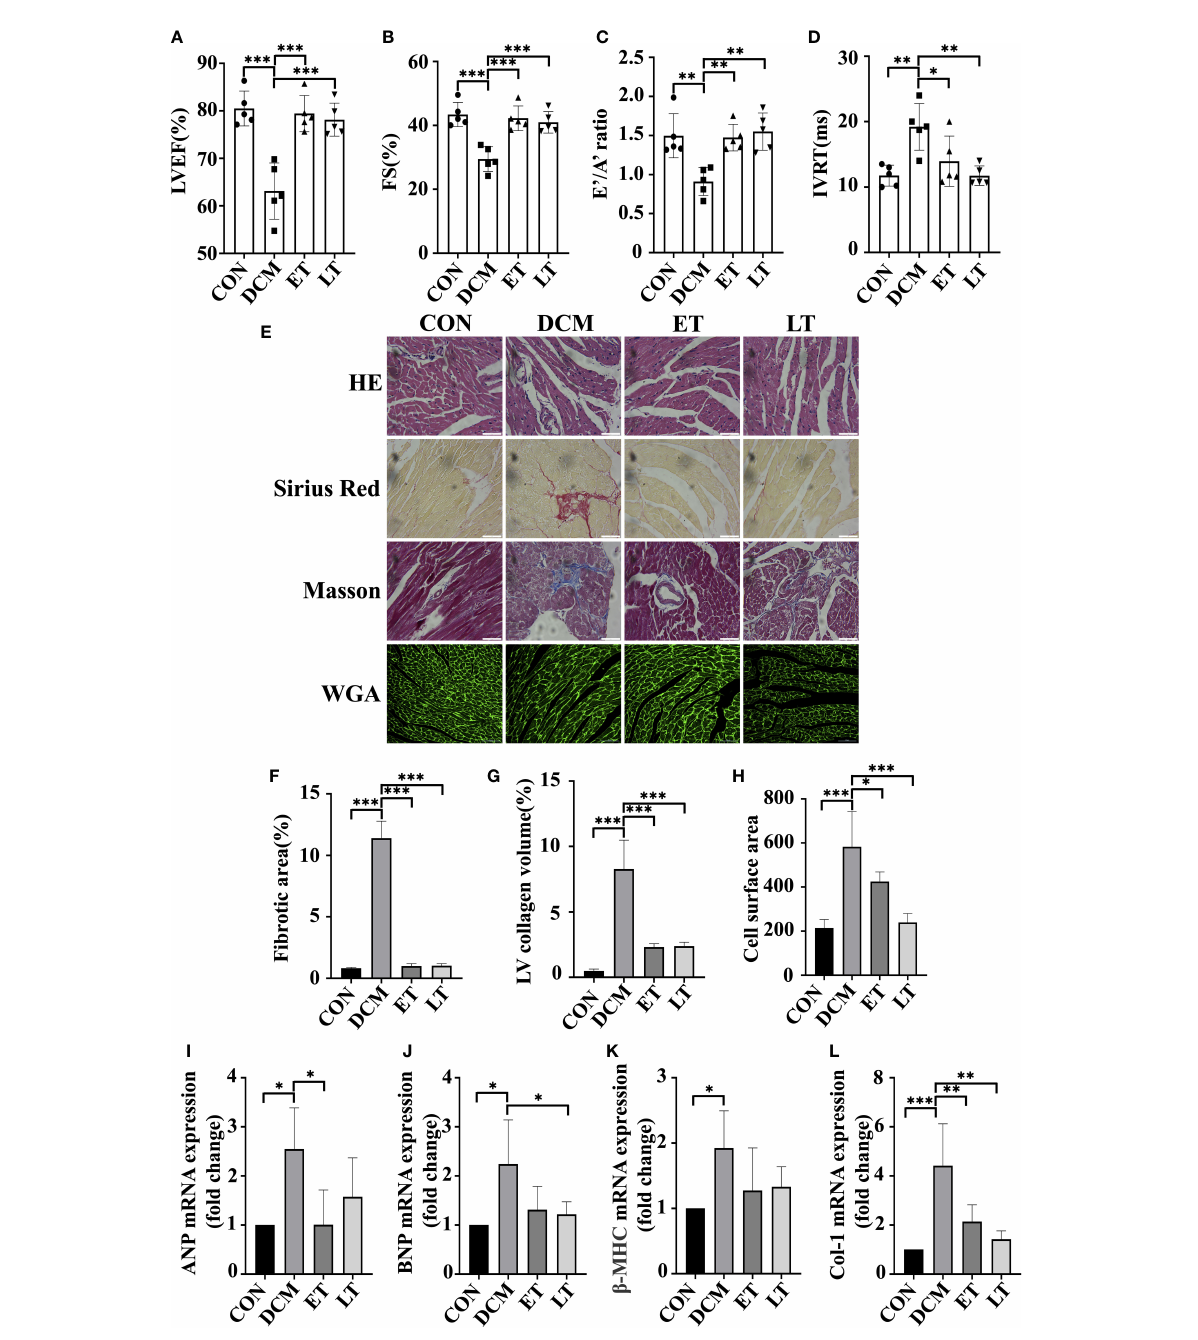
FIGURE 2 The effect of SNO on cardiac function in diabetic mice. Indices of cardiac systolic function, (A) Left ventricular ejection fraction (EF %). (B) Fractional shortening (FS %). Indices of cardiac diastolic function, (C) Early-to-late septal annulus motion in diastole (E ’ /A ’ ) and (D) Isovolumic relaxation time (IVRT). (E) HE staining, Sirius red staining, Masson trichrome staining and WGA staining of mouse hearts. Scale bar=50 mm. (F) The percentage of fi brotic area was quanti fi ed. (G) The percentage of LV collagen area was quanti fi ed. (H) Quantitative analysis of cardiac myocyte cross-sections. (I-L) Relative ANP, BNP, b -MHC and Col-1 mRNA expression normalized to GAPDH. * represents p < 0.05; ** represents p < 0.01; *** represents p <